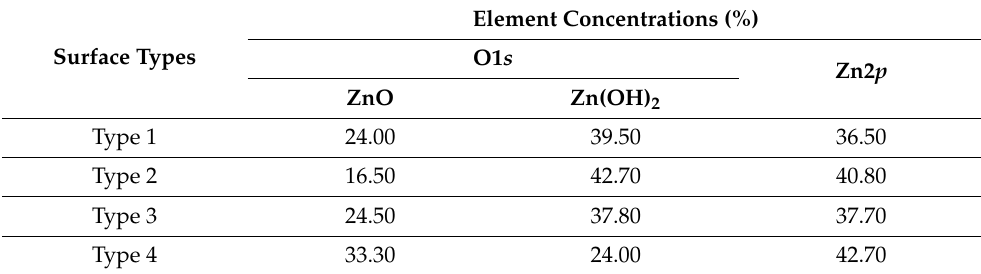
Table 5. Composition of the surface oxide-hydroxide layer on “smooth”, chemically etched and laser textured zinc